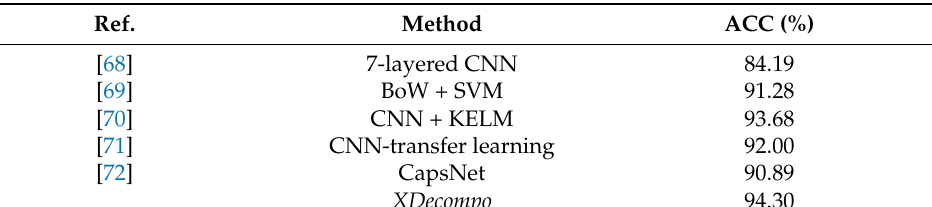
Table 11. Comparison between the result obtained by XDecompo and different approaches that used the same labelled dataset for the classification of brain tumour images.